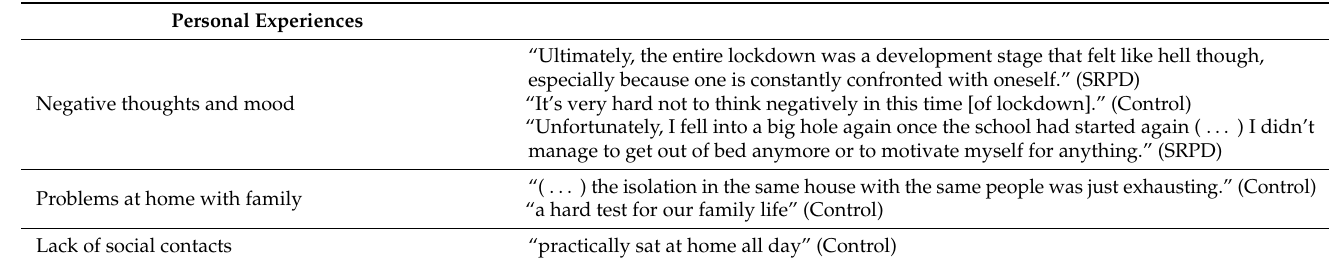
Table 3. Qualitative assessment of personal experiences and strategies with group